Question: Summarize what this figure shows in one sentence.
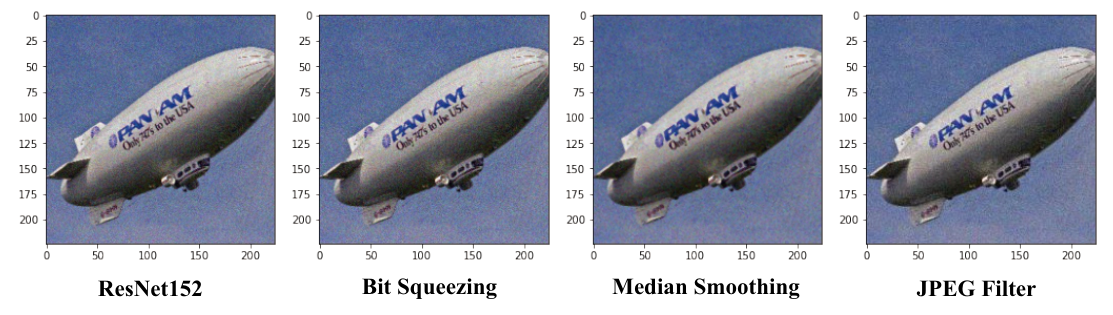
Answer: Bit squeezing, median, and JPEG defensive techniques and the needed amount of noise to defend the model effectively. Under the HopSkipJump attack, bit squeezing seems to add more noise than median and JPEG filters, reducing its confidence score.